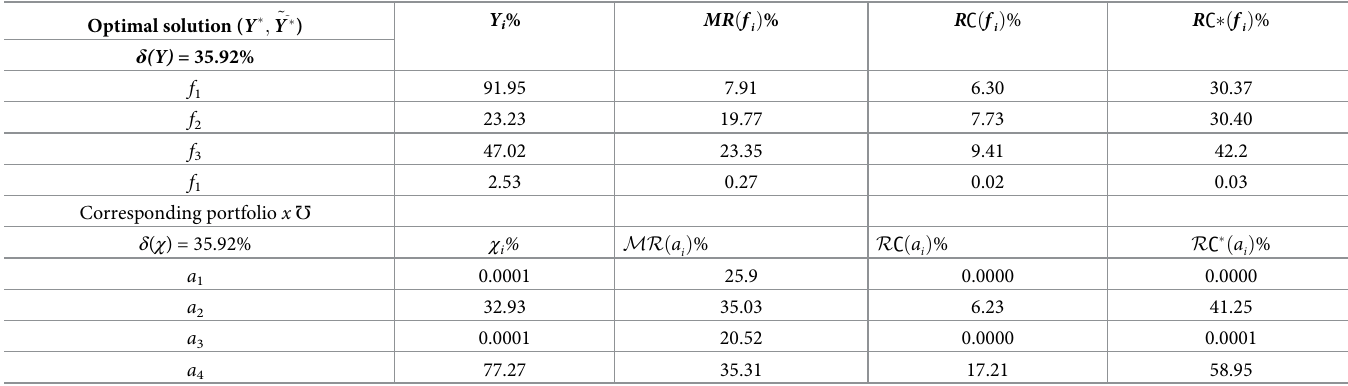
Note: Statistics are described in Table